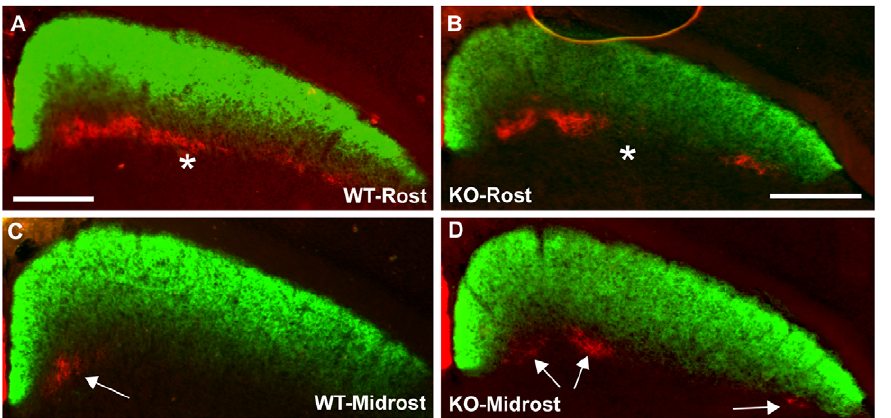
Figure 4. Deletion of Ten-m3 does not disrupt segregation of ipsilateral and contralateral RGC axons or ipsilateral targeting with respect to depth. A–D: Coronal sections through rostral (A,B) and midrostral (C,D) levels of the SC in WT (A, C) and Ten-m3 KO (B, D) mice following injections of CTB tagged to red or green fluorescent labels in each eye. Medial is to the left and dorsal to the top in all images. Contralateral terminals (green) form a continuous, dense band in the most superficial layers of the SC in both WT and KO. Ipsilateral axons (red) form clusters in the deep part of the retino-recipient layers of the SC in both WT (A,C) and KO (B,D). Ipsilateral terminals are segregated from contralateral in both WT and KO. In WTs, the ipsilateral axons form a patchy band across the entire mediolateral extent of the nucleus in the rostral SC (A, *) but become quickly confined to one or two patches in medial SC at slightly more caudal levels (arrow in C). In KOs, ipsilateral axons appear slightly less numerous in rostral sections, being absent from some parts of the mediolateral axis of the SC at this level (*). Notably, they do not become confined to medial SC at more caudal levels, but remain scattered across the mediolateral extent of nucleus (arrows in D). Scale bars: 500 m m. Scale in A also applies to C; scale in B also applies to